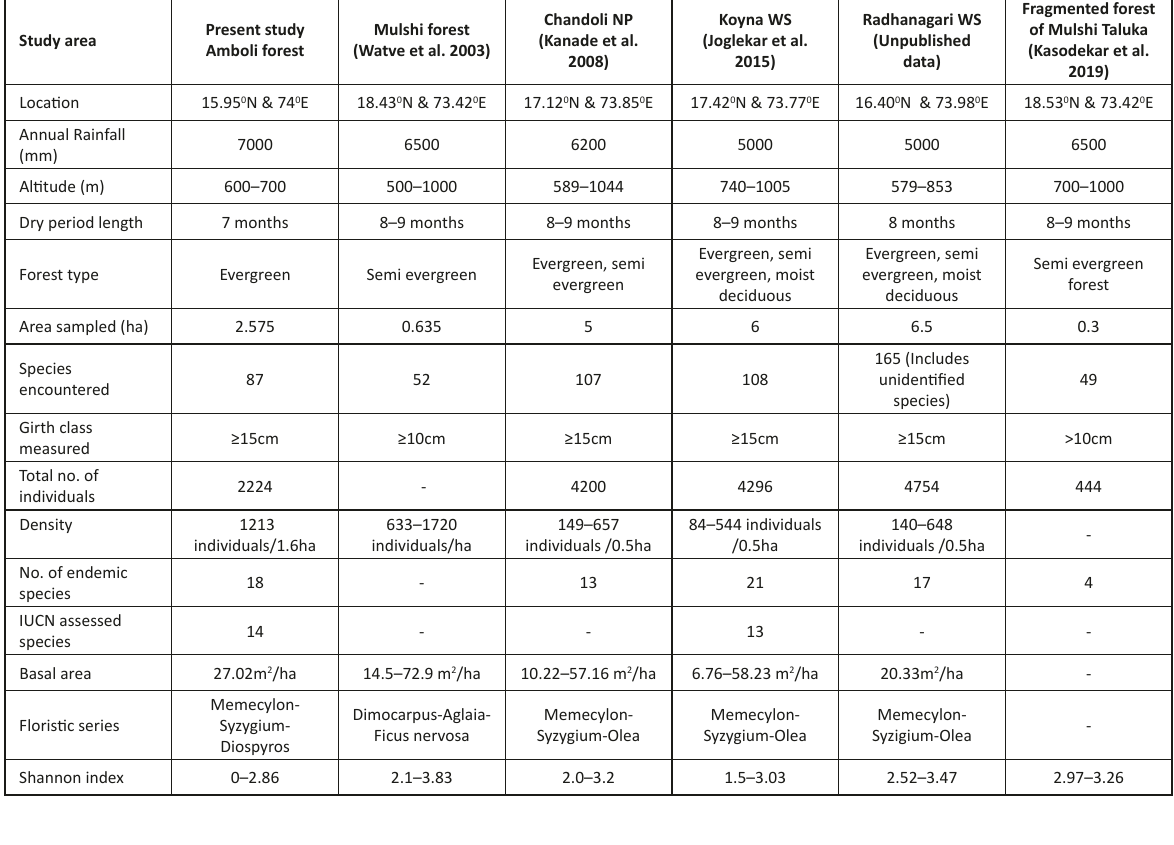
Table 4. Woody plant species diversity in Amboli vis-à-vis PAs and RF from northern Western Ghats.